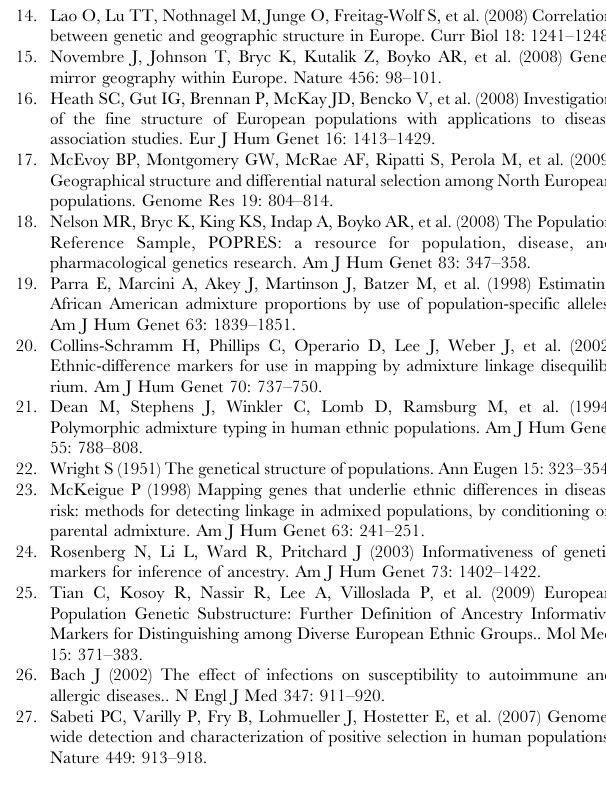
Figure S1 Distribution of the latitudinal (panel A) and longitudinal error (panel B) when using a panel of 994 SNPs selected on the POPRES samples to predict the coordinates of origin of the HapMap Phase 3 CEU samples. We consider as ground truth for the CEU samples our predictions using all 450K available SNPs. Found at: doi:10.1371/journal.pone.0011892.s001 (0.13 MB